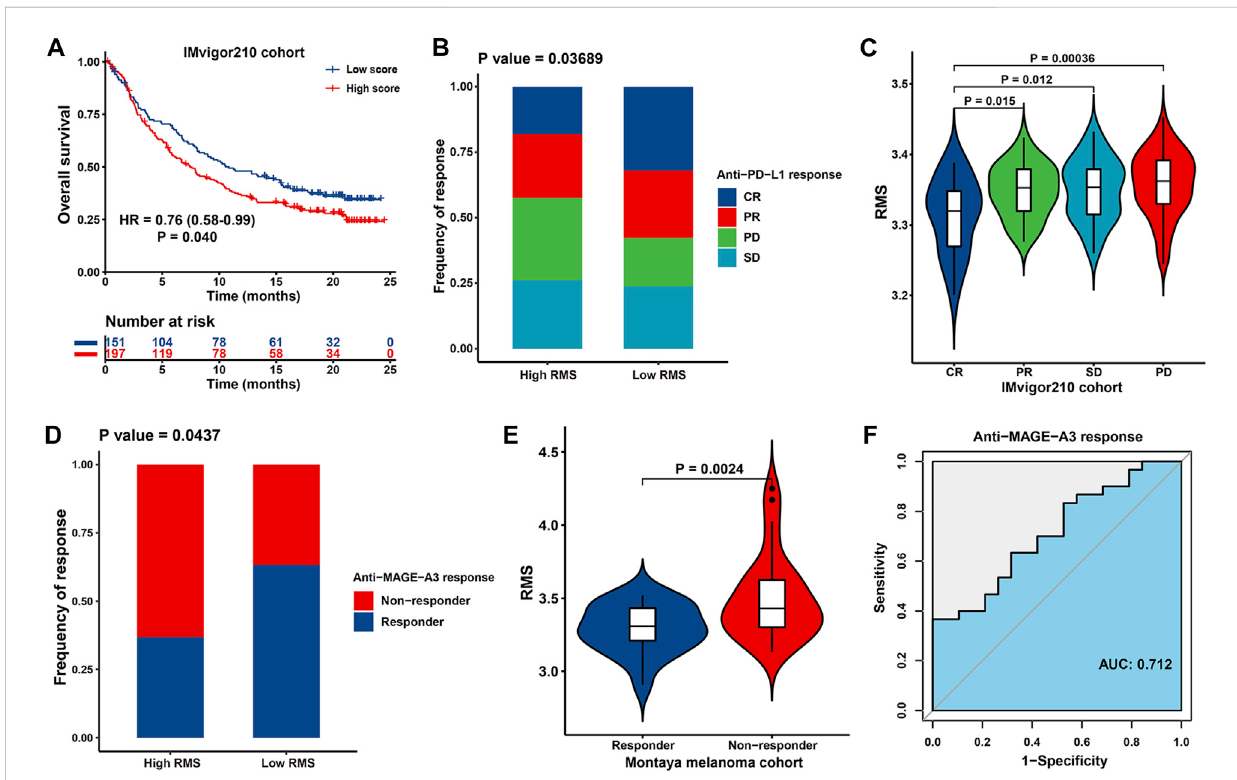
FIGURE 11 The association between the RMS and ef fi cacy of immunotherapy in two cohorts. (A) Kaplan-Meier curve for OS of RMS-low and -high patients in IMvigor210 cohort. (B) Bar plot showing the fractions of different clinical responses to anti-PD-L1 immunotherapy in RMS-high or -low group in IMvigor210cohort. (C) ViolinplotdisplayingthedistributionoftheRMSinfourgroupsaboutclinicalresponsetoanti-PD-L1therapyinIMvigor210cohort. (D) Barplotrevealingtheproportionsofdifferentclinicalresponsestoanti-MAGE-A3immunotherapyinhigh/lowRMSgroupinMontoyamelanoma cohort. (E) Violin plot displaying the distribution of the RMS in four groups about clinical response to anti-MAGE-A3 treatment in Montoya melanoma cohort. (F) ROC curve describing the predictive performance of the RMS in evaluating patients ’ response to anti-MAGE-A3 immunotherapy in Montoya melanoma